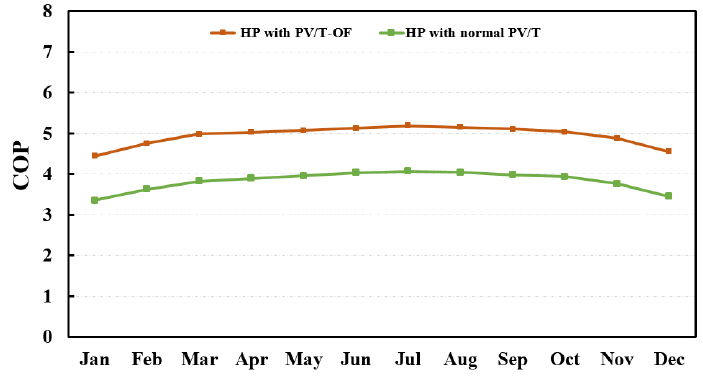
Figure 10. Heat pump COP.